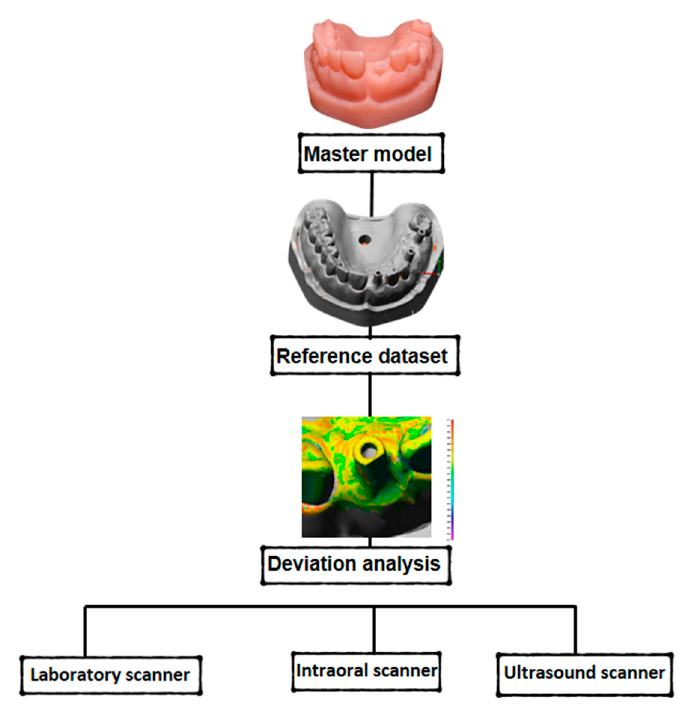
Figure 1. Representation of methodology used in this study. Acrylic-resin cast containing dental implants was digitized for use as reference data set. The scan was performed with ultrasound, laboratory scanner and intraoral scanner. Measurement error was calculated as deviation between scanned cast compared with reference